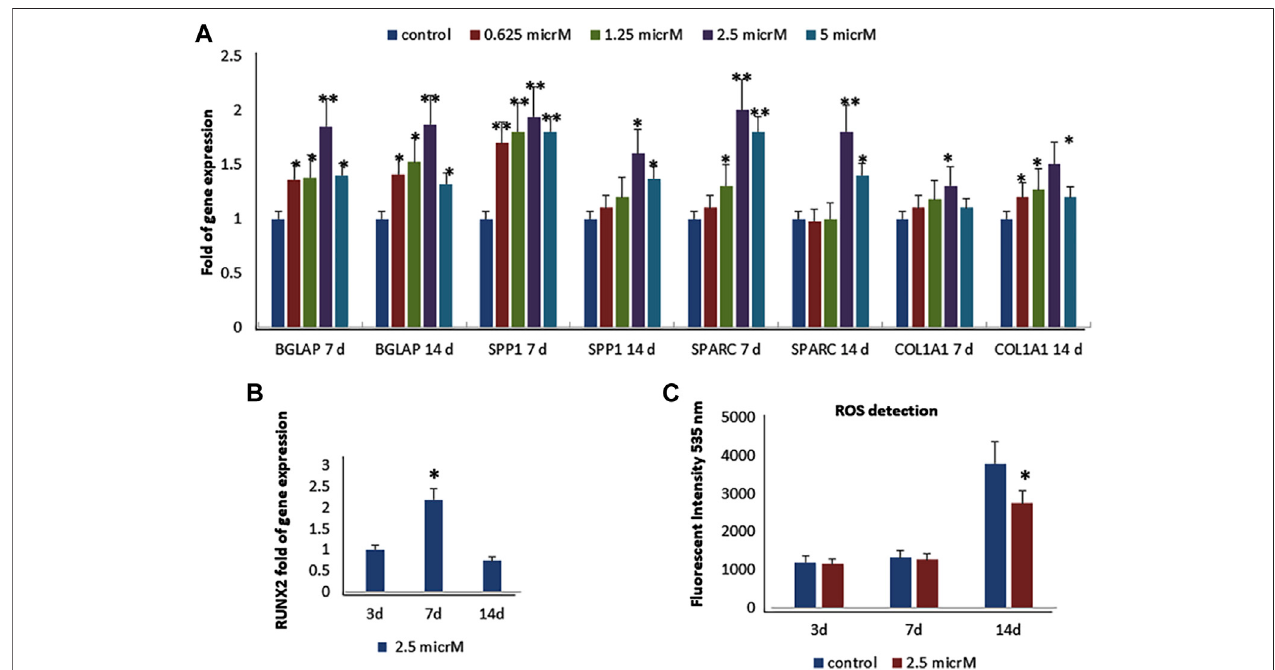
FIGURE 2 | Effects of fi setin supplementation during osteogenic differentiation. The upregulation of osteogenic genes was much more evident when fi setin was supplemented at a concentration of 2.5 µM (A) . Expression of RUNX2 in treated cells decreased after 7 days of differentiation (B) . ROS levels were modulated by fi setin supplementation at the late differentiation phase (14 days of differentiation) (C) . Analyses were performed in hMSCs cultured in the presence of the osteogenic differentiation medium. * p < 0.05; ** p < 0.01; *** p < 0.005.